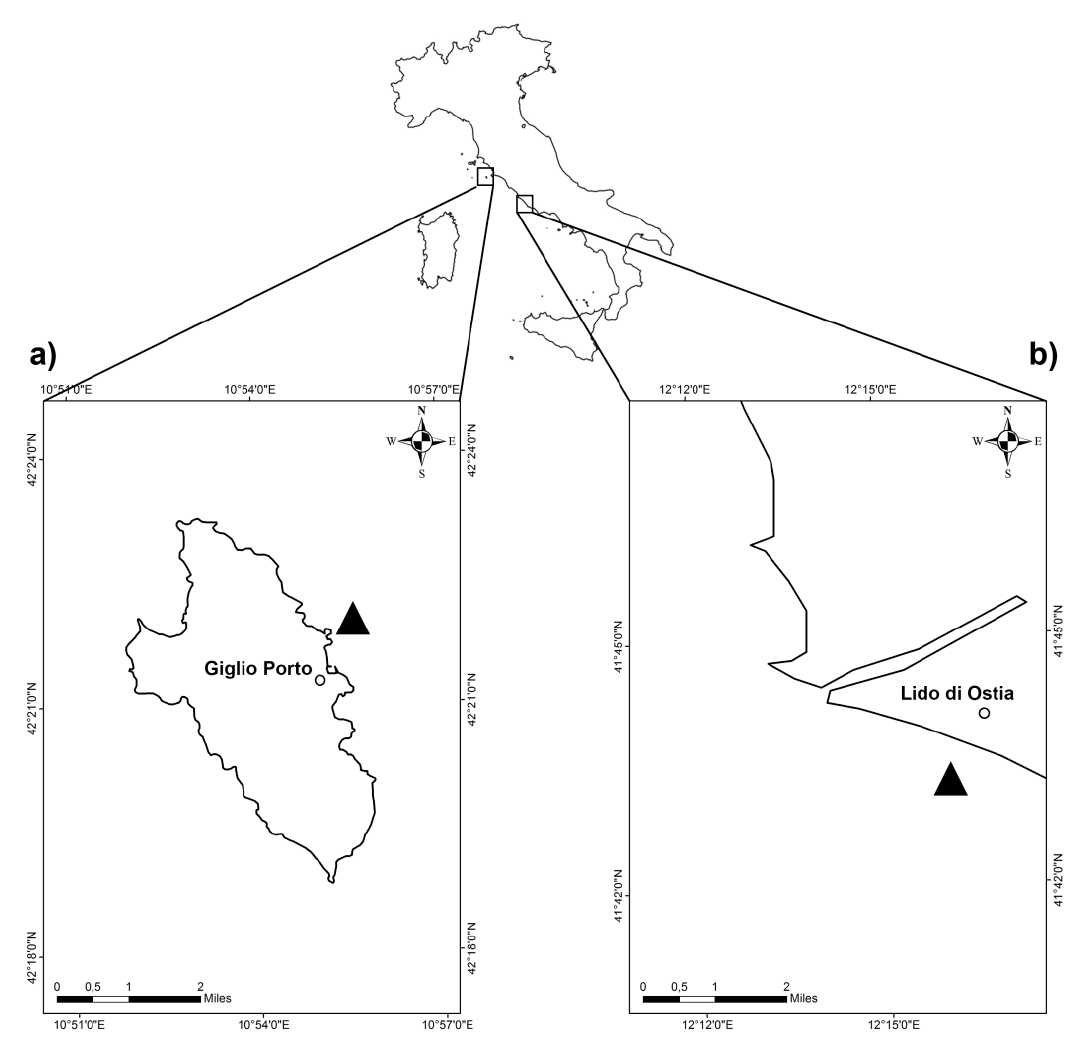
Figure 1. Study areas ( a ) Giglio Island and ( b ) Latium coast, with the locations of the sampling sites (black triangles) being Punta del Lazzaretto and Lido di Ostia, respectively.